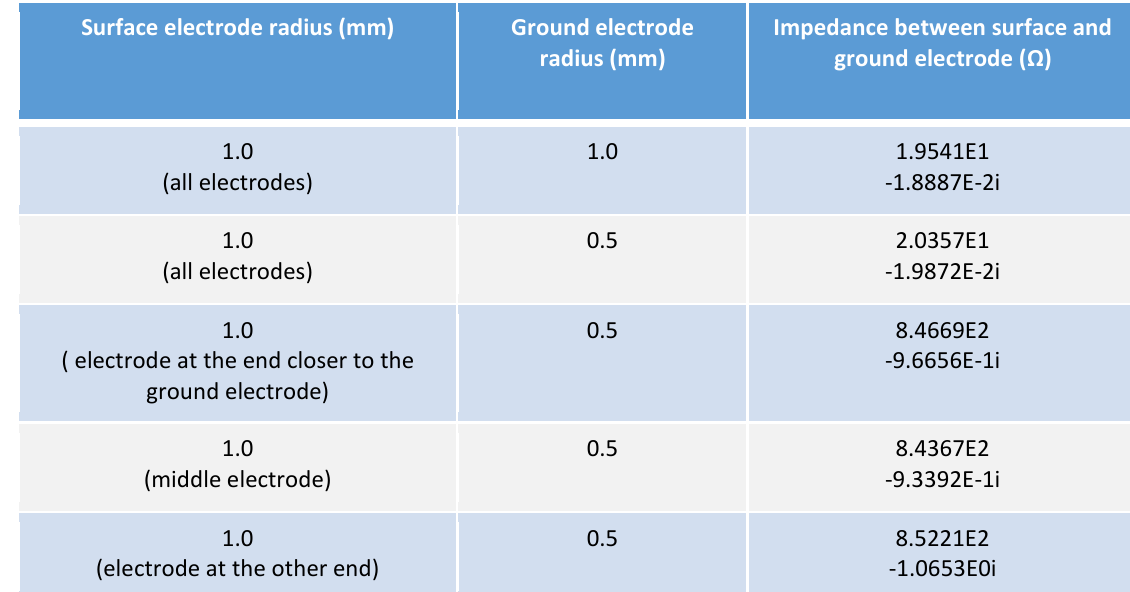
Table.16: Impedance measurements at 1MHz with both all and one of the 48 surface electrodes as terminals (12 electrodes in 4